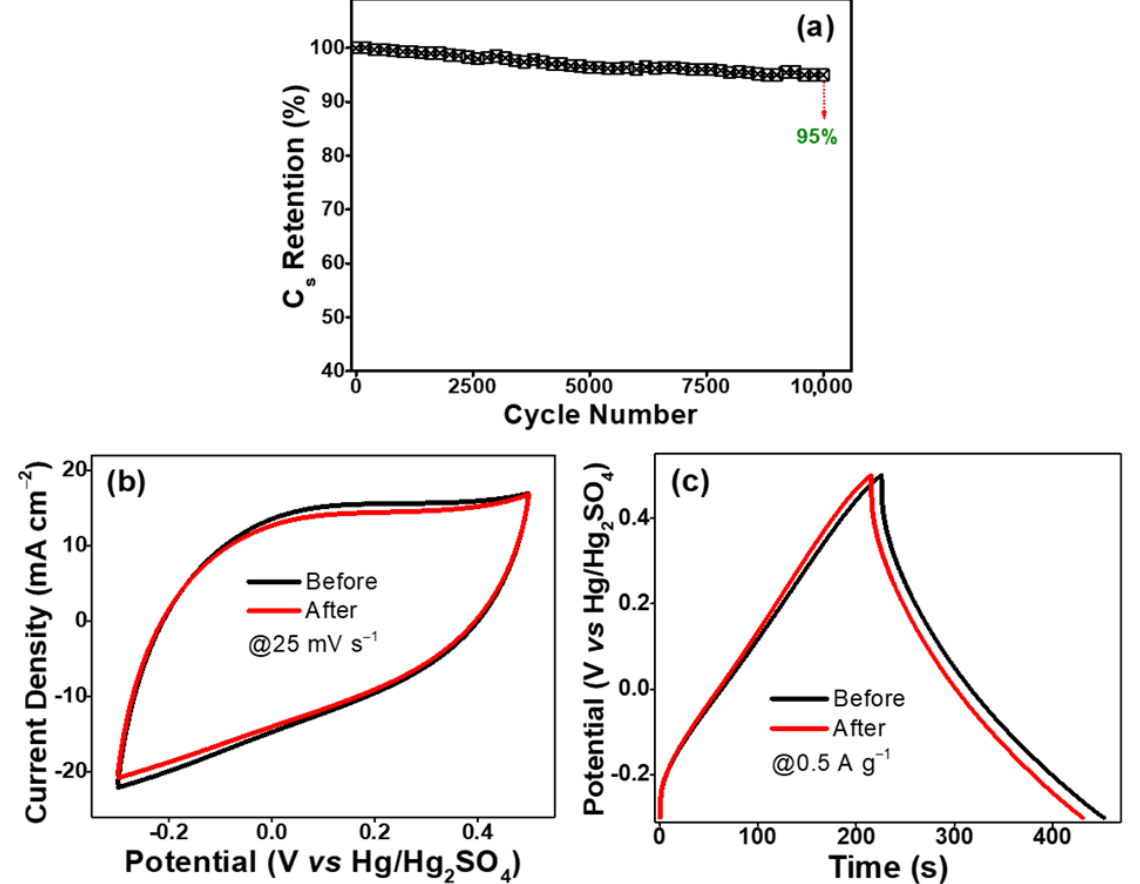
Figure 7. Electrochemical performance of ATC: ( a ) cycle performance, ( b ) CV curves comparison, and ( c ) GCD curves